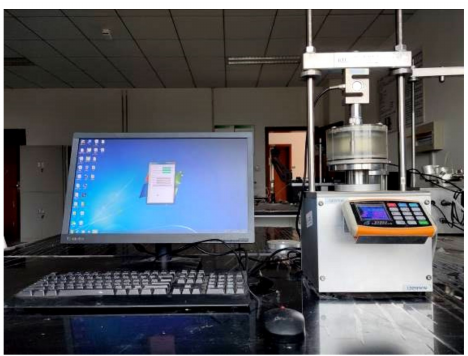
Figure 2. Fully automatic consolidation and expansion test instrument.